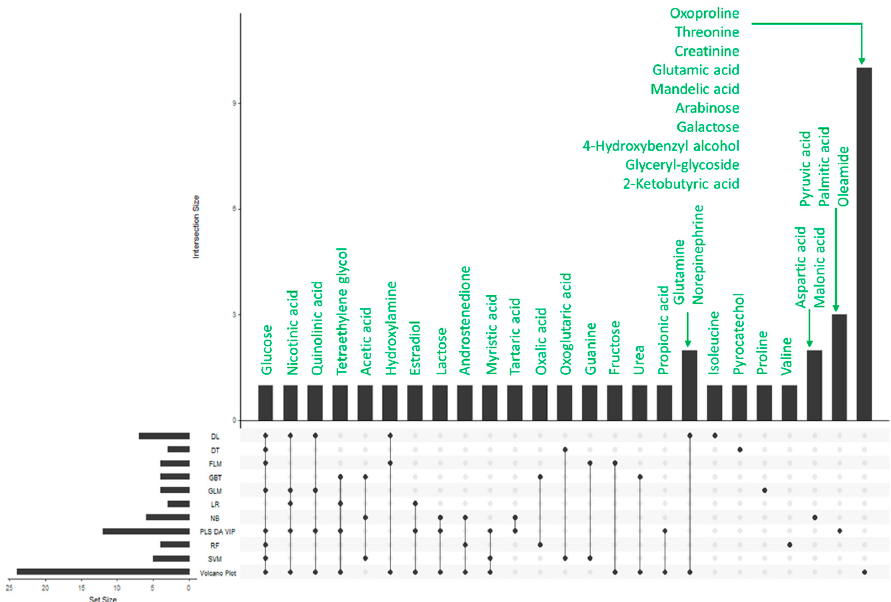
Figure 3. UpSet representation showing the metabolites selected as significant by a given classification model (horizontal) in addition to multiple models selecting a given metabolite (vertical).